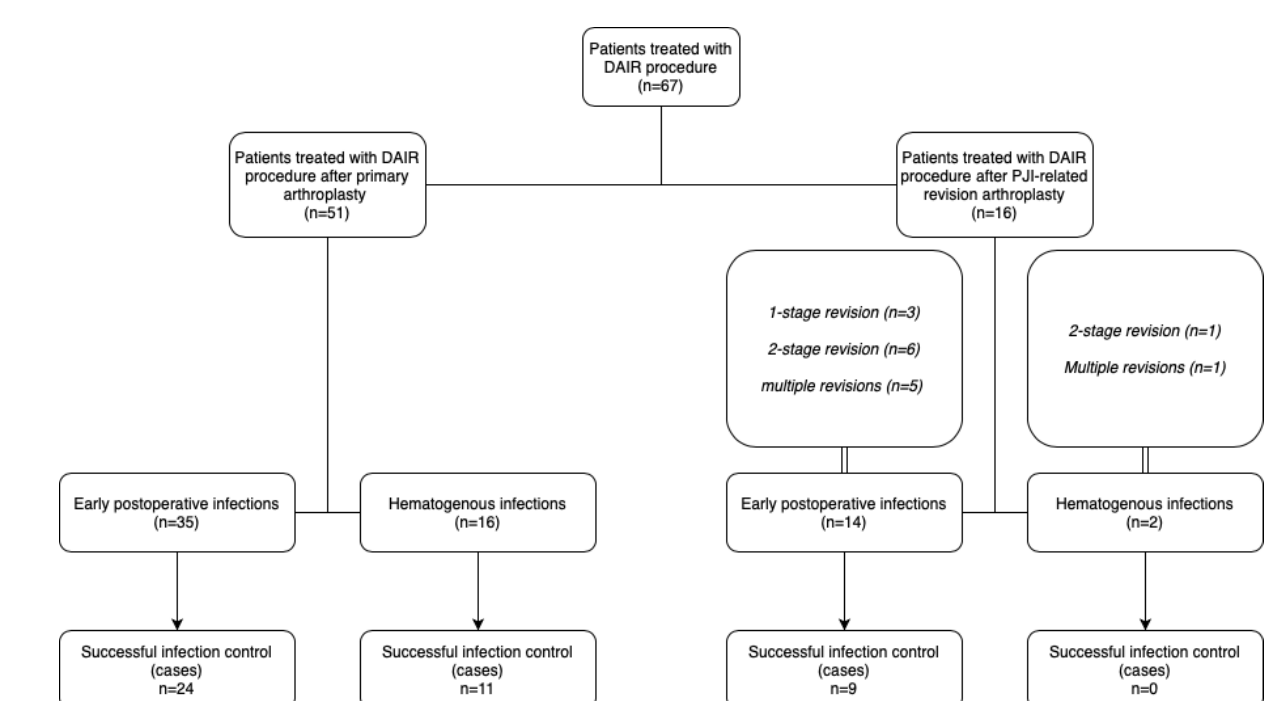
Figure 1. Flow diagram showing the infection characteristics, previous PJI procedures and number of successfully controlled infections.